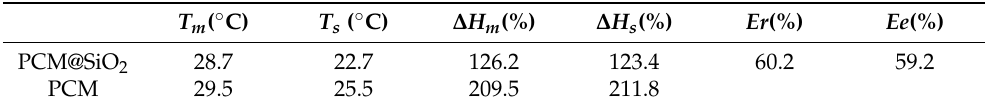
Figure 7. Crystallizing ( a ) and melting ( b ) DSC curves of PCM and PCM@SiO 2 . Table 1. Phase change properties of PCM and PCM@SiO 2 .